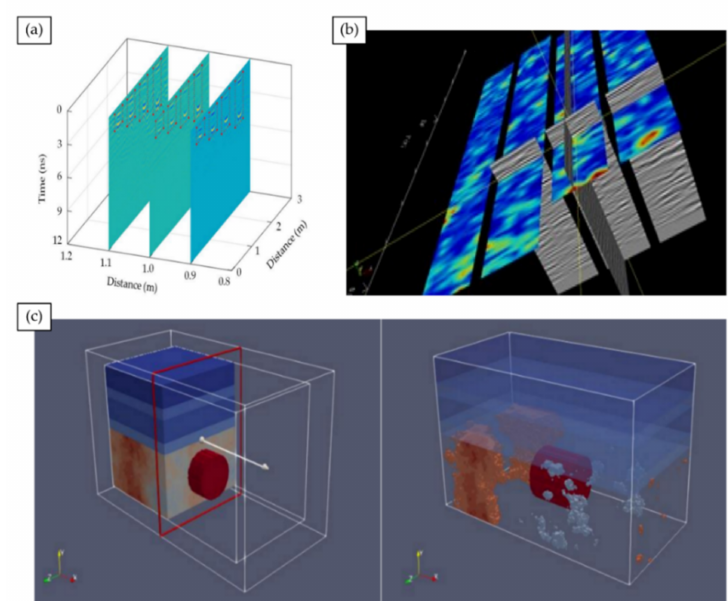
Figure 6. Mechanisms for improved contextualisation of 3D GPR datasets. Time-slicing performed ( a ) horizontally [100] or ( b ) vertically [102] can improve perception of relative depths and 3D feature shape. ( c ) Volumetric reconstruction increases feature faithfulness to reality, reducing human memory dependency, but processing remains highly involved